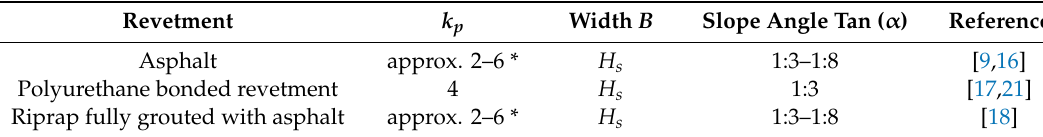
Table 1. Parametrization of the wave load in the design of di ff erent kinds of monolithic or coherent revetments with a PEF